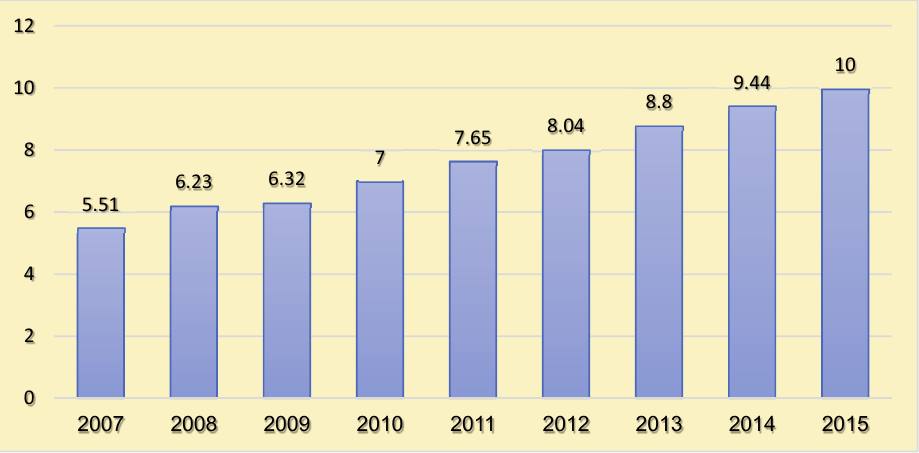
Fig. 1. Foreign Tourist Arrivals in Indonesia,